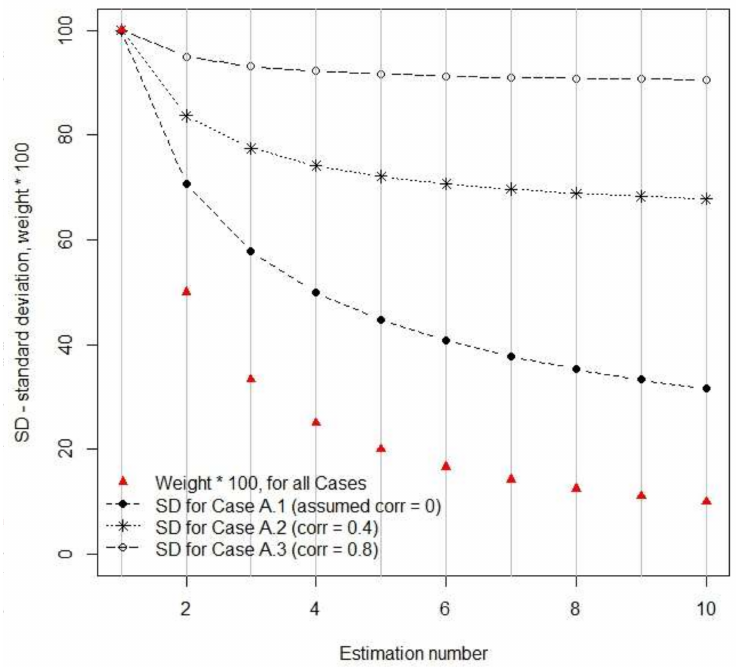
Figure 3. Demonstration of Case A in terms of relative standard deviation of a composite estimation (CE), making use of 1–10 estimates sequentially assuming different residual error correlations. The weights are the same for all subcases, and shown as red triangles; the values of the weights are scaled by a factor of